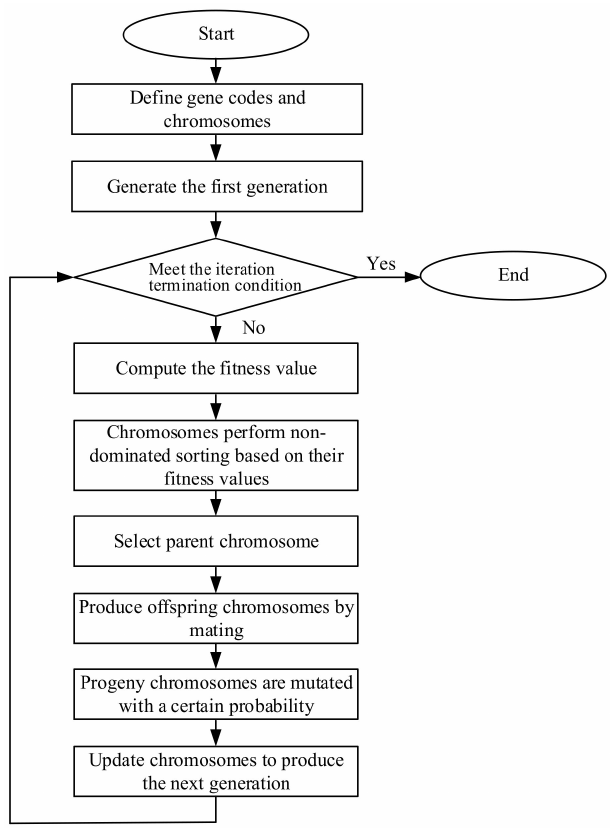
Figure 4. Execution flow chart of non-dominated sorting genetic